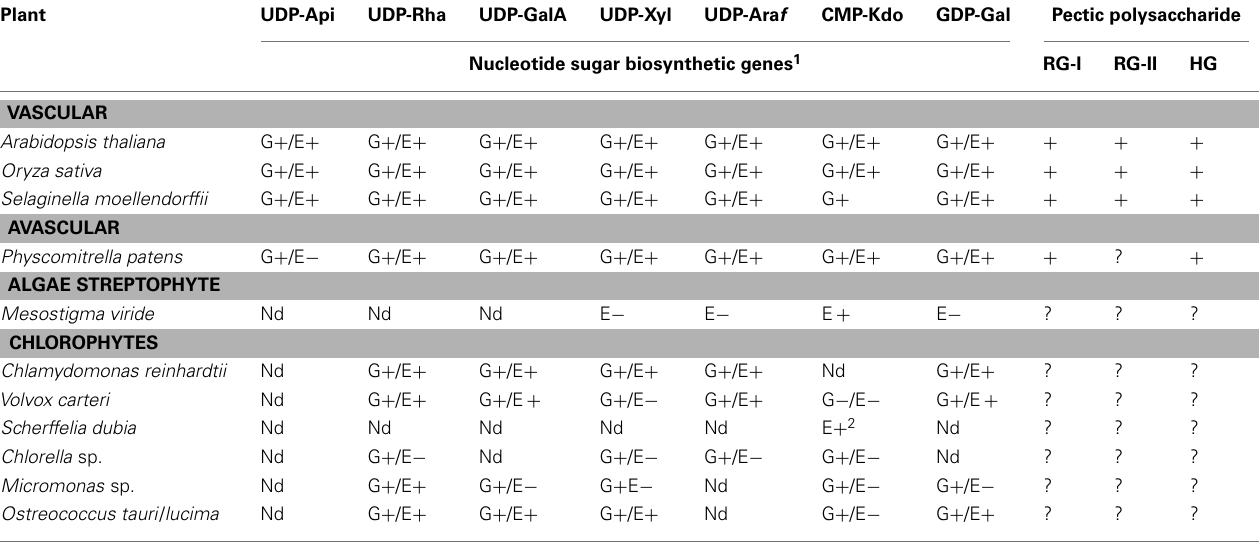
Table 1 |The occurrence of selected nucleotide sugar biosynthetic genes and pectic polysaccharides in green plants.